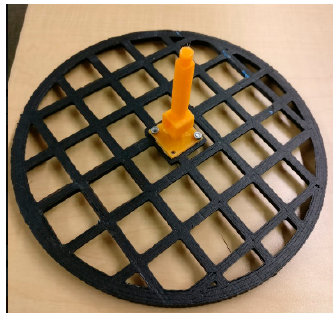
Figure 11. Rod assembled to the platform.